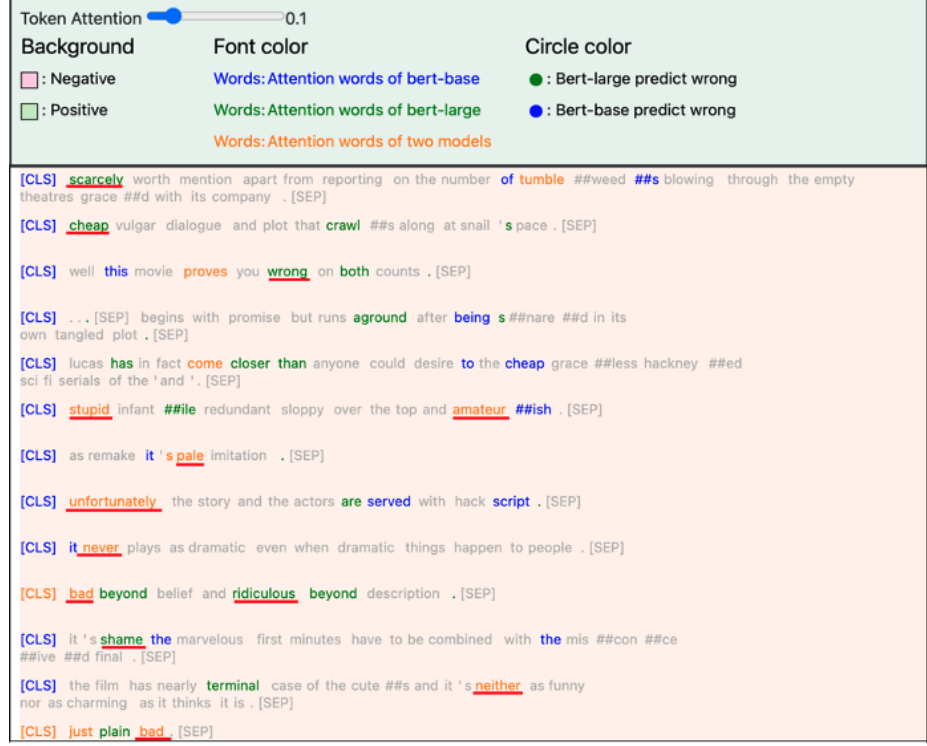
Figure 21. Many negative words are attention words of both models and some negative words are attention words that belong to bert-large